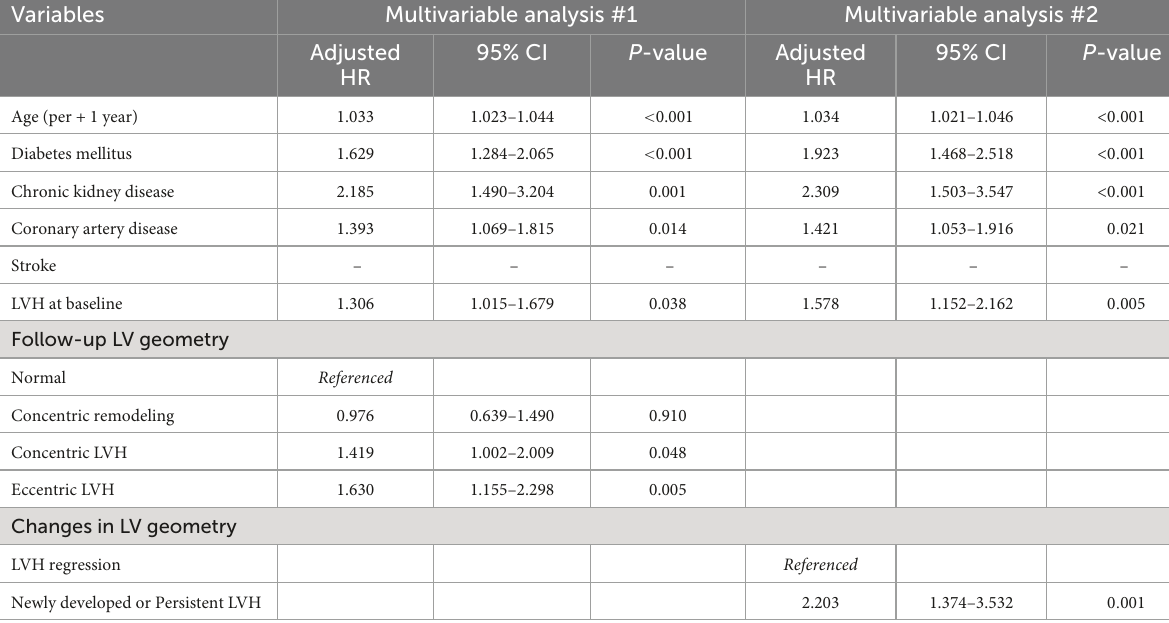
TABLE 2 Associations between LV geometry and the composite study